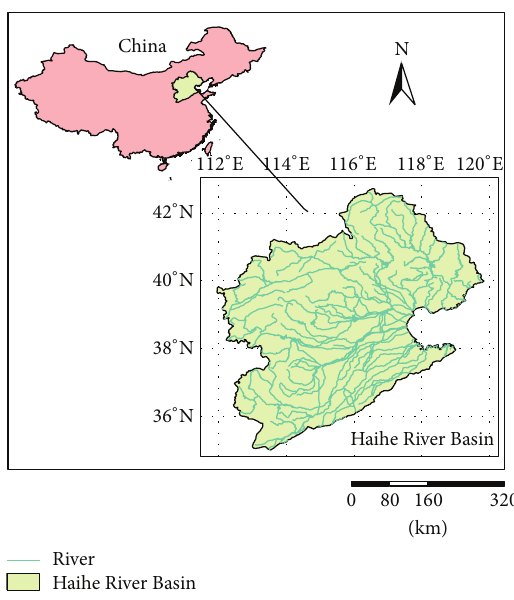
Figure 1: The location of the Haihe River